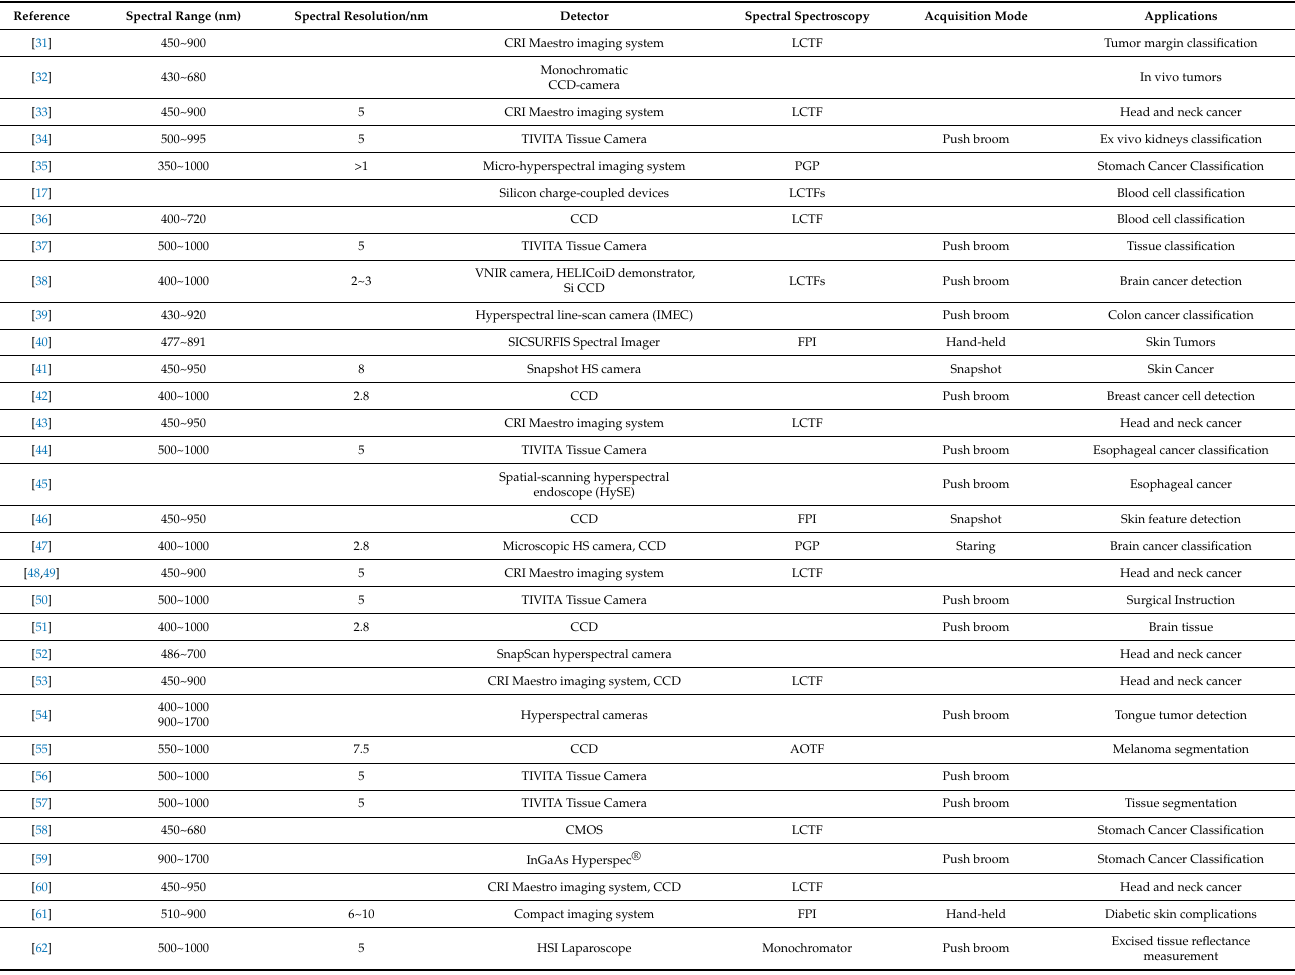
Table 1. Application areas of hyperspectral imaging systems and